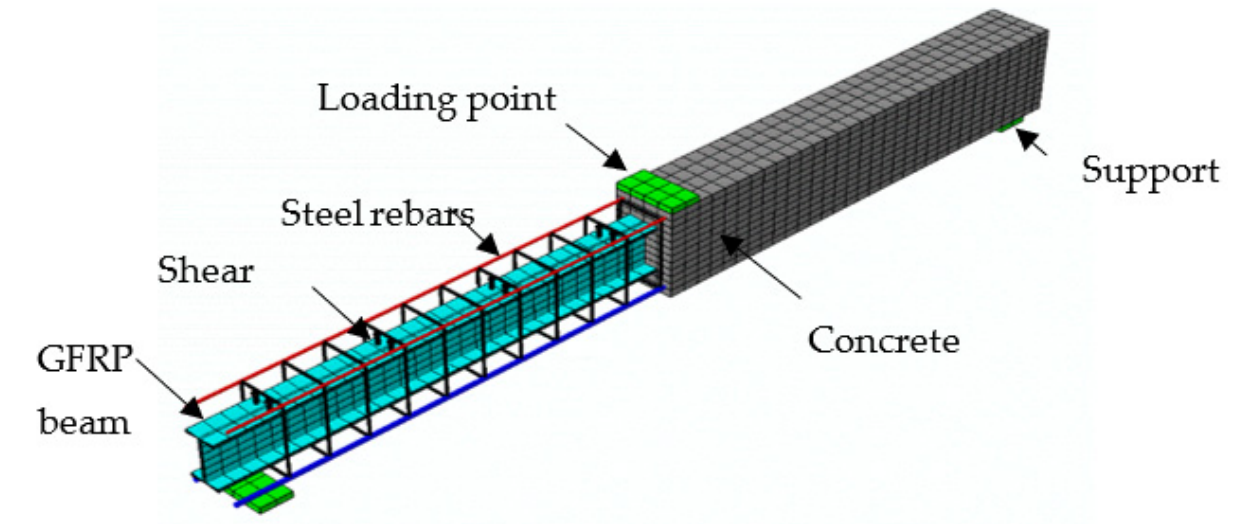
Figure 15. FE mesh of the analyzed specimen CGC for static analysis.